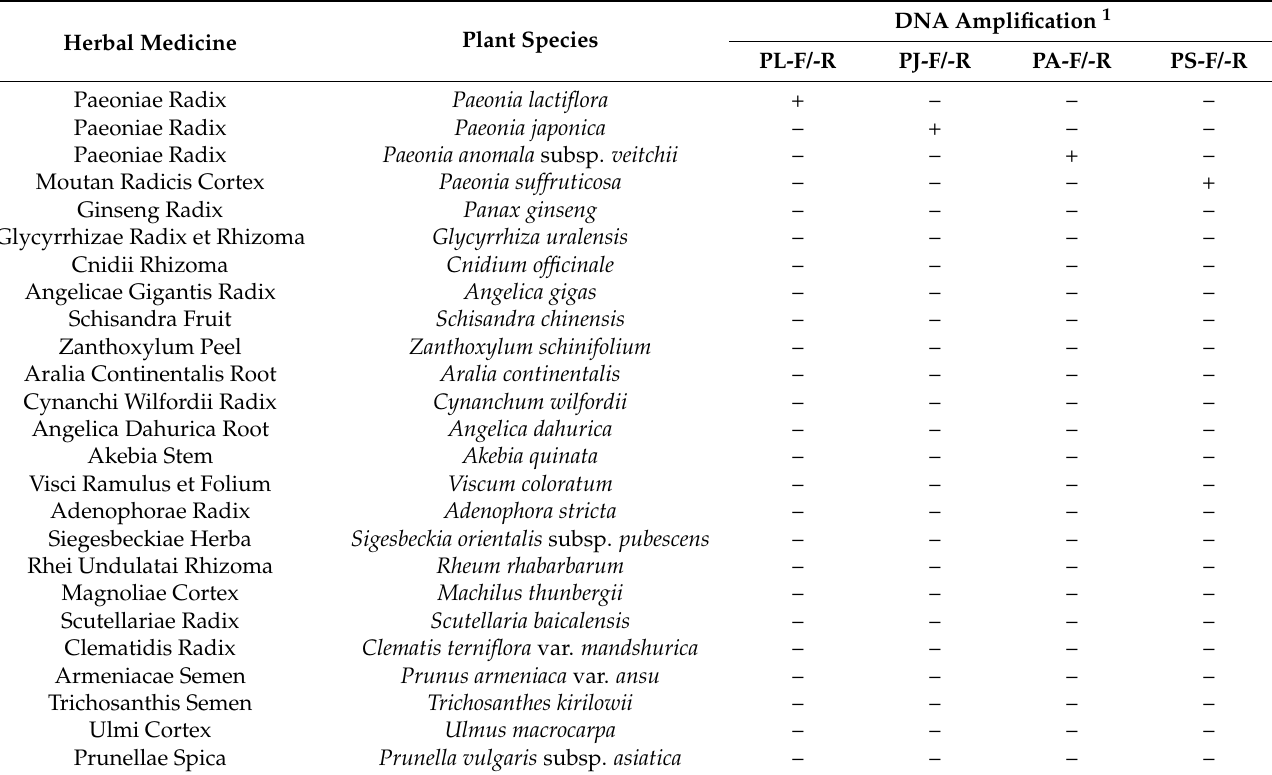
Table 2. Analysis of the specificity of SCAR primers using 21 herbal medicine-related plant